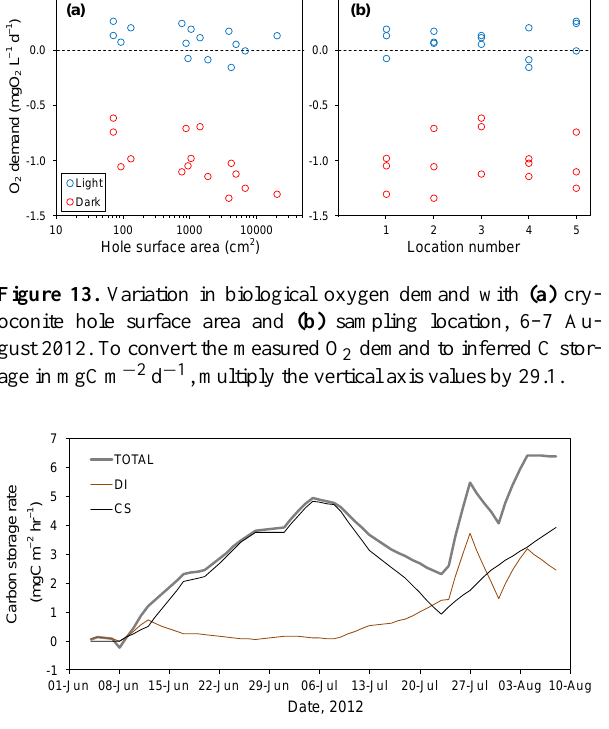
Figure 14. Seasonal variation in C fluxes from the field site, showing individual contributions from DI and CS surfaces. Daily fluxes are plotted, which were calculated by linear interpolation of ∼ weekly incubation measurements and quadrat